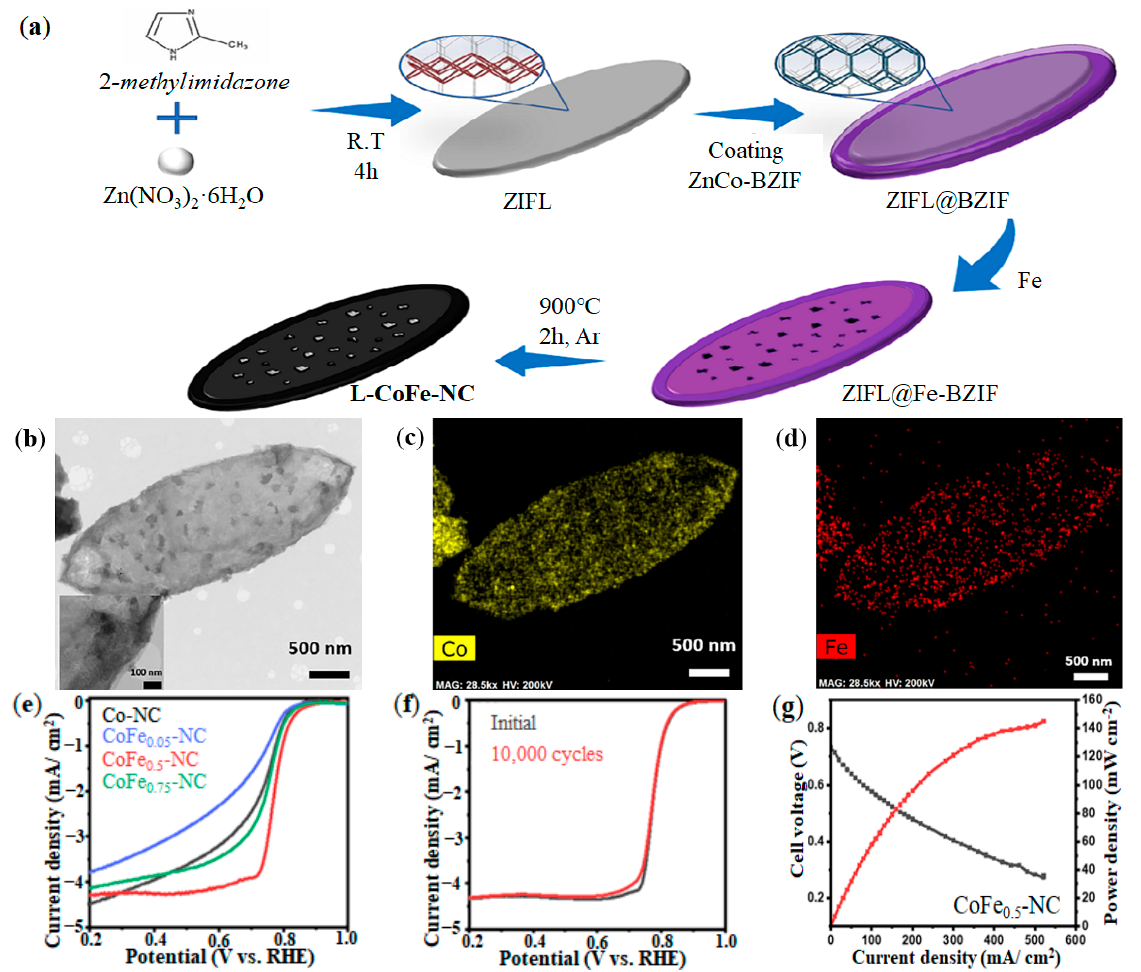
Figure 10. Synthesis method and performance of L-CoFe-NC catalyst: ( a ) Synthesis process of L- CoFe-NC catalyst; ( b ) TEM image of L-CoFe-NC; ( c ) Elemental mapping image of Co; ( d ) Elemental mapping image of Fe; ( e ) ORR activity; ( f ) ORR durability; ( g ) PEMFC performance. Adapted with permission from Ref. [124]. Copyright 2021 John Wiley and Sons.